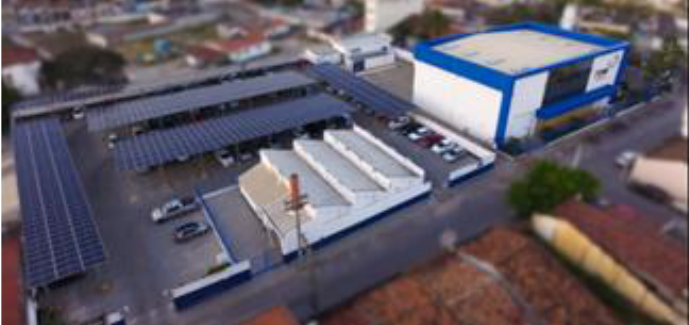
Figure 1. ITEMM Microgrid.